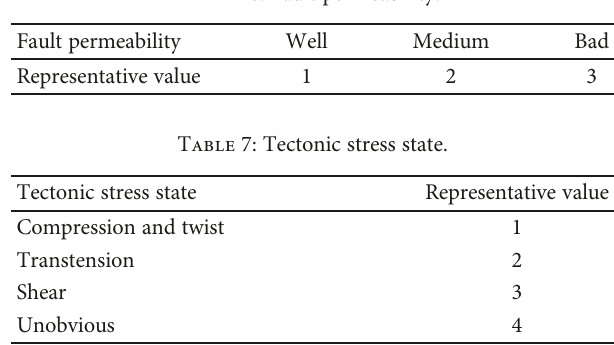
Table 6: Fault permeability.